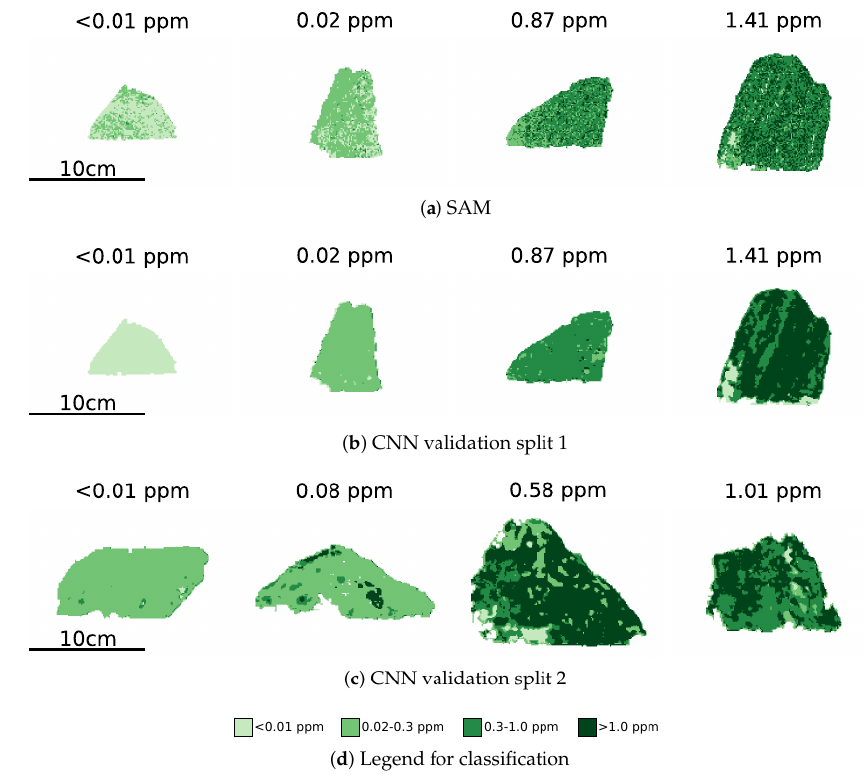
Figure 7. Four grade classification on validation sets. Classification results are coloured by one of the four grade classifications, as shown in the